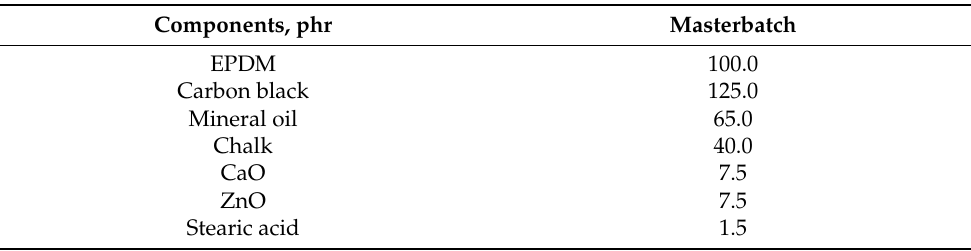
Table 1. General composition of ethylene-propylene-diene monomer (EPDM) masterbatch, parts per hundred of rubber (phr).